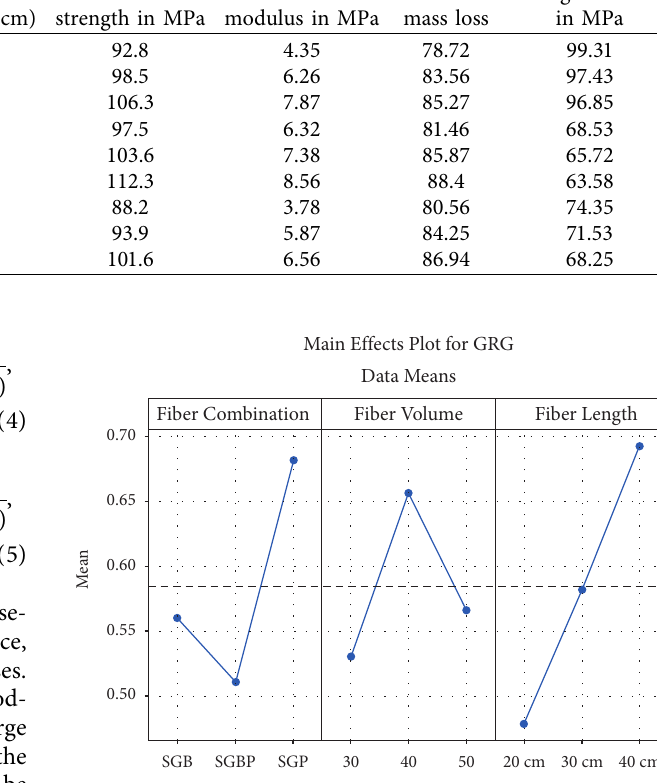
Figure 7: Graphical representation of the main effect plot on output response of input